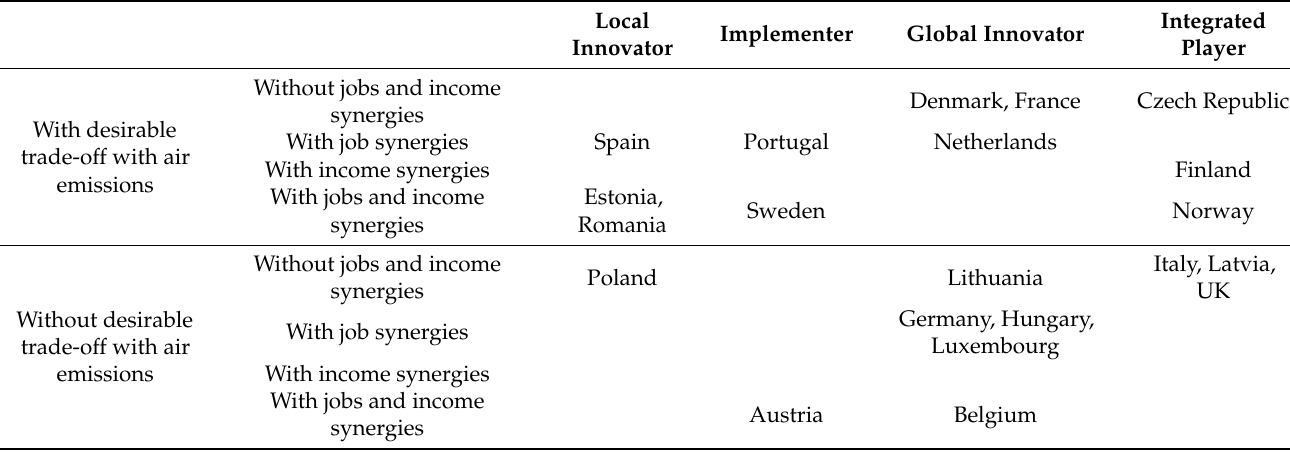
Table 13. KT models matrix by